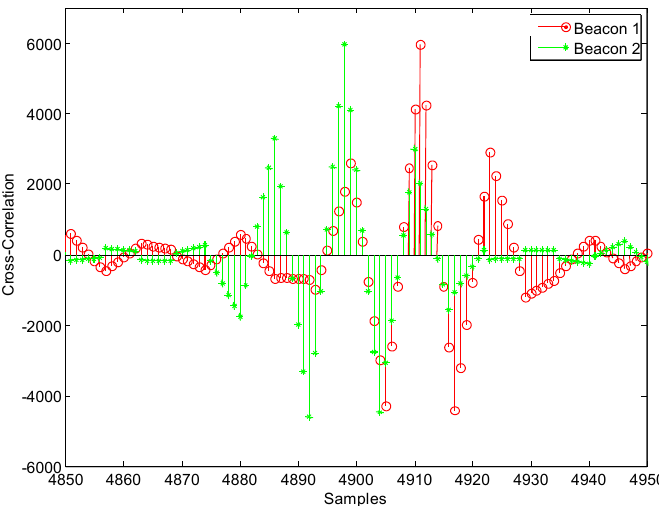
Figure 9. Beacon detection by applying CC, for a modulation symbol formed by four carrier cycles ( m =